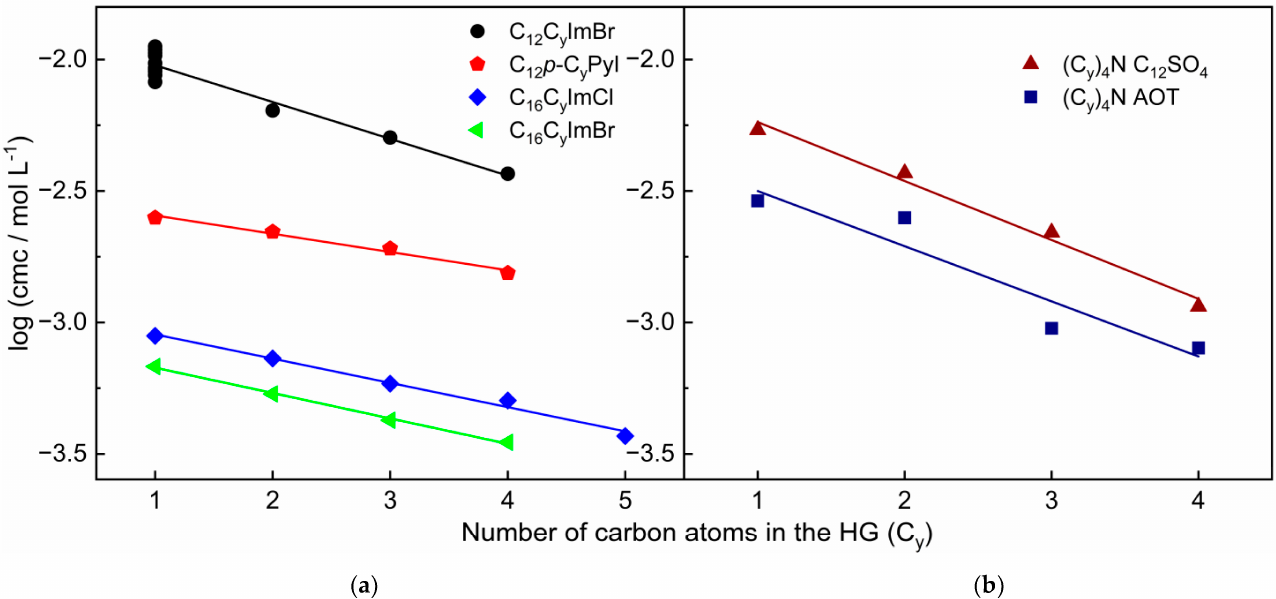
Figure 5. Dependence of log cmc on the number of carbons in the head group side chain (C y ) of ( a ) cationic ionic liquid-based surfactants and ( b ) anionic ionic liquid-based surfactants. Data taken from conductivity measurements; see references [80,91,126,151,152].